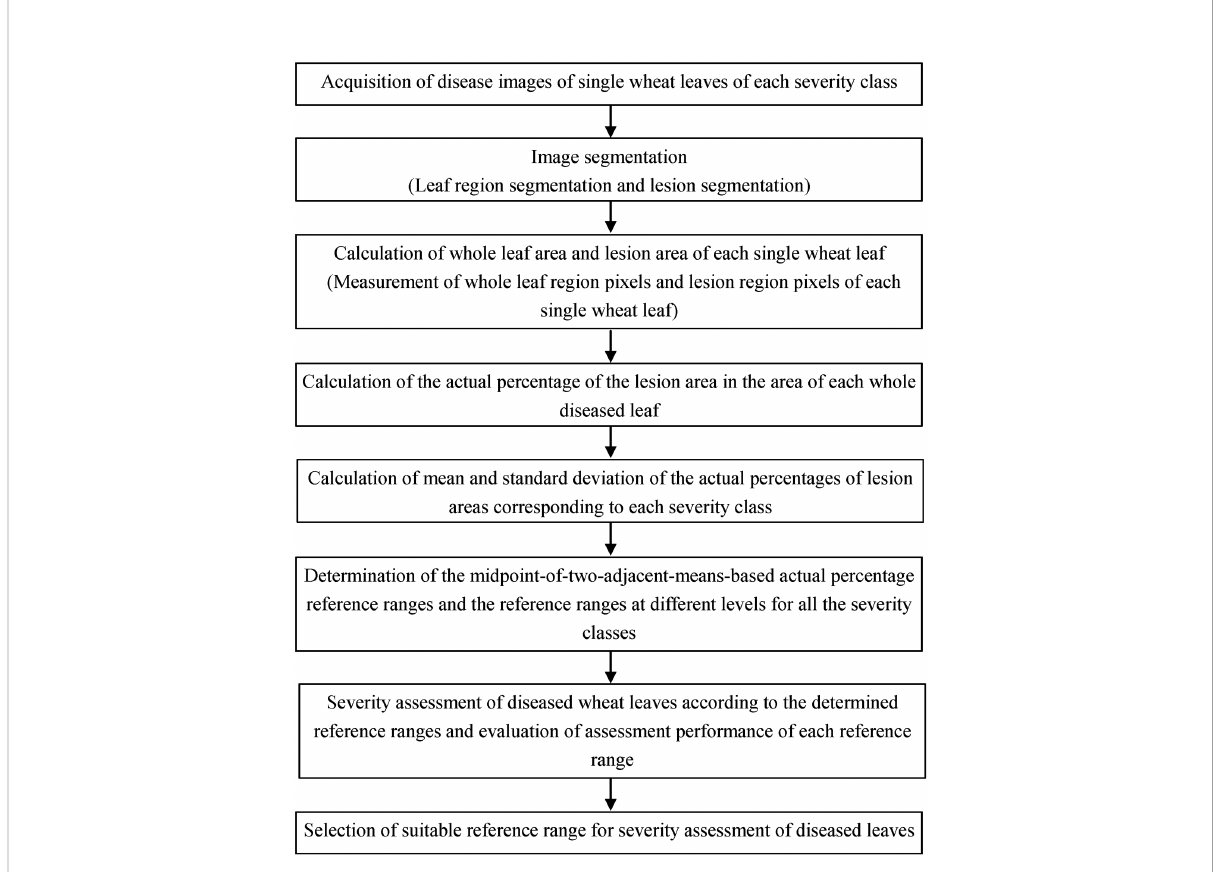
FIGURE 1 Work fl ow diagram for determining the reference ranges for disease severity assessment based on the actual percentages of lesion areas corresponding to each severity class and assessing the severity of wheat stripe